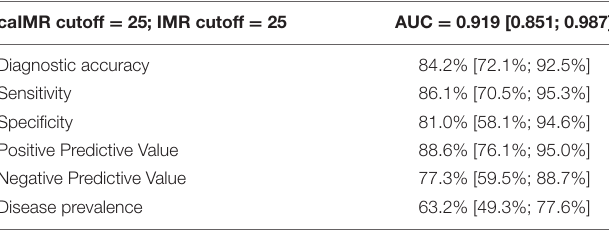
TABLE 2 | Diagnostic characteristics of caIMR using the wire-derived IMR as standard reference in 57 vessels.